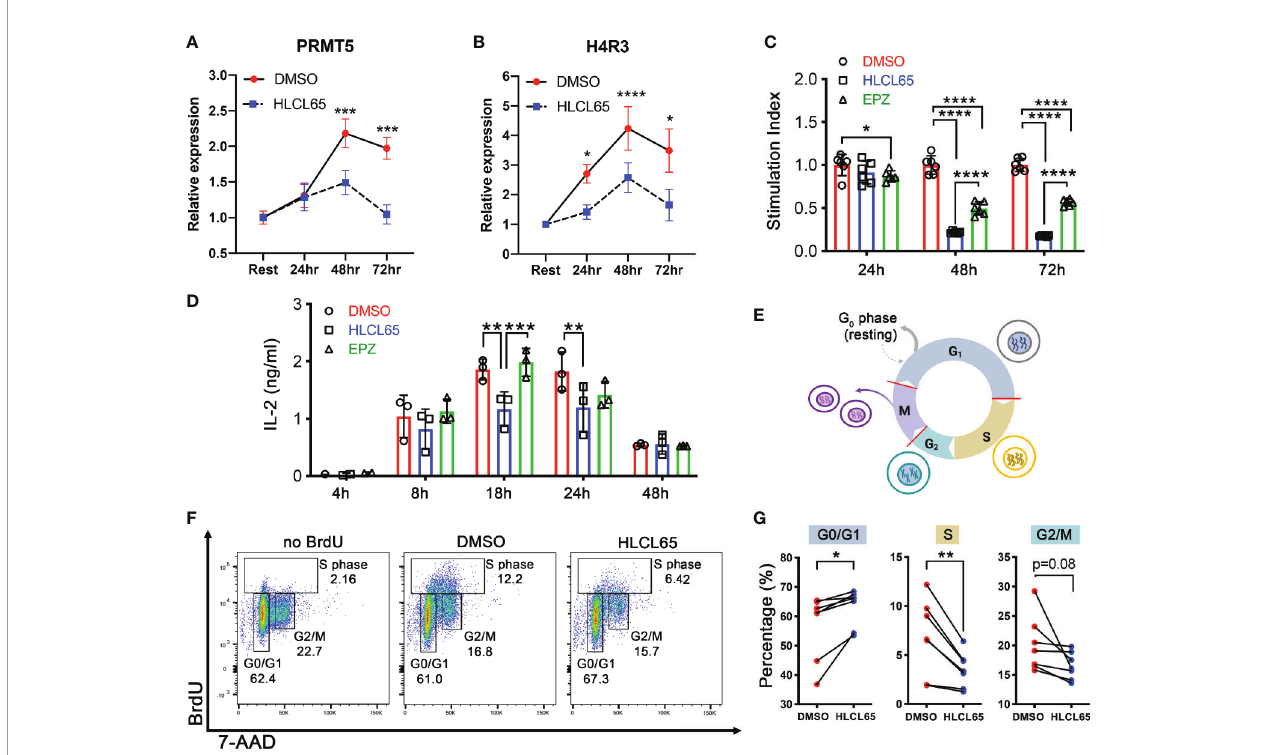
FIGURE 1 | PRMT5 inhibition arrests TCR-induced cell cycle progression at the G1/S checkpoint. (A, B) mTh1 cells were activated on anti-CD3/CD28 coated plates, treated with 5 µM HLCL65 or vehicle control (DMSO) and harvested at the time of plating (resting) or 24, 48 or 72h post-plating. They were analyzed by immunoblot with PRMT5 (A) or H4R3 (B) . Data plotted represent relative protein expression at indicated timepoints. Plots are combined 4-6 experiments, n=8-13/ timepoint/condition. (C) mTh1 cells were plated on anti-CD3/CD28 coated plates, treated with vehicle (DMSO), 5 m MHLCL65 or 5 m M EPZ, and pulsed with tritiated 3 H-thymidine at 24, 48 or 72h post-plating with vehicle or HLCL65. Cells were harvested 16-18h later. This is a representative experiment with 6 technical replicates/group, analyzed by two-way ANOVA with Tukey ’ s multiple comparisons test. (D) Supernatants from mTh1 cells plated on anti-CD3/CD28 coated plates were collected at 4h, 8h, 18h, 24h and 48h ± HLCL65, EPZ or vehicle and analyzed for IL-2 cytokine expression by ELISA. Data pooled from 3 independent experiments. Data analyzed by two-way ANOVA with Tukey ’ s multiple comparisons test. (E) Diagram of the cell cycle stages including Gap 1 (G1), Synthesis (S), Gap 2 (G2) and Mitosis (M). Cells represent the stage the cell is in at each phase of the cell cycle. Red lines on the cell cycle represent cell cycle checkpoints. Created with BioRender.com, modi fi ed from a template. (F) Flow cytometry plots of activated mTh1 cells demonstrating the gating strategy and representative results in the negative control (no BrdU), vehicle (DMSO) or PRMT5 inhibitor (2.5 µM HLCL65). (G) Quanti fi cation of the results from analyses in (F) , corresponding to four independent experiments. Graphs for Gap 0/Gap 1 (G0/G1), Synthesis (S) and Gap 2/mitosis (G2/M). Results analyzed by paired t-test, n=7 pairs. Graphs are line or bar graphs representing mean ± SD with individual data points plotted (A – D) or before-after (plot individual points) (G) . *p < 0.05, **p < 0.01, ***p < 0.001, ****p <